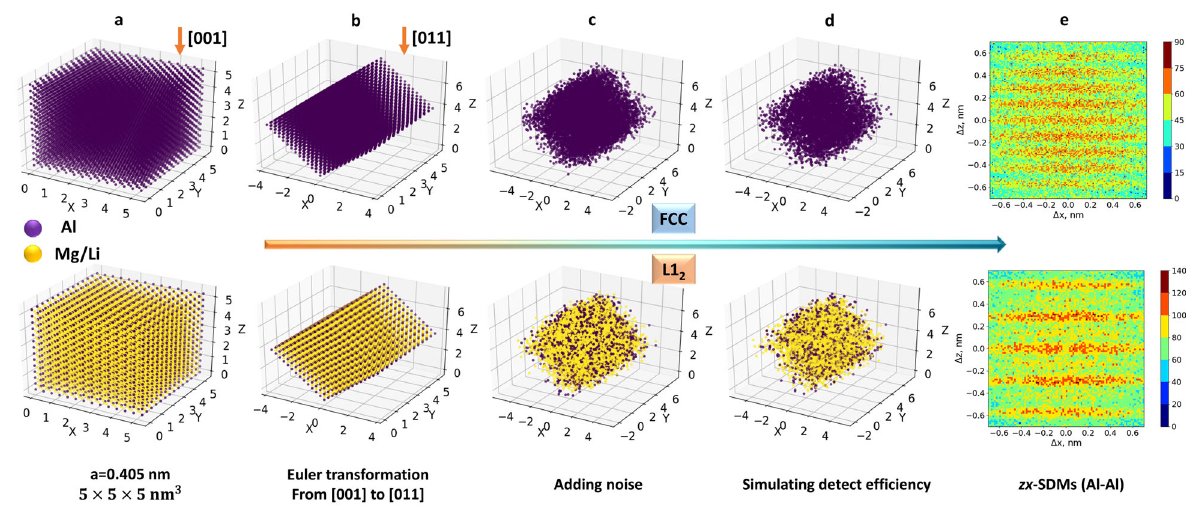
Fig. 2 Procedure to build crystal structure library and generate simulated zx -SDMs dictionary. a Generating supercell; b making Euler transformation; c adding Gaussian noise to shift atoms in x, y, z directions; d removing part of atoms; e simulated zx -SDMs of Al – Al pairs. Note that the Mg and Li atoms are not separately labeled in the L1 2